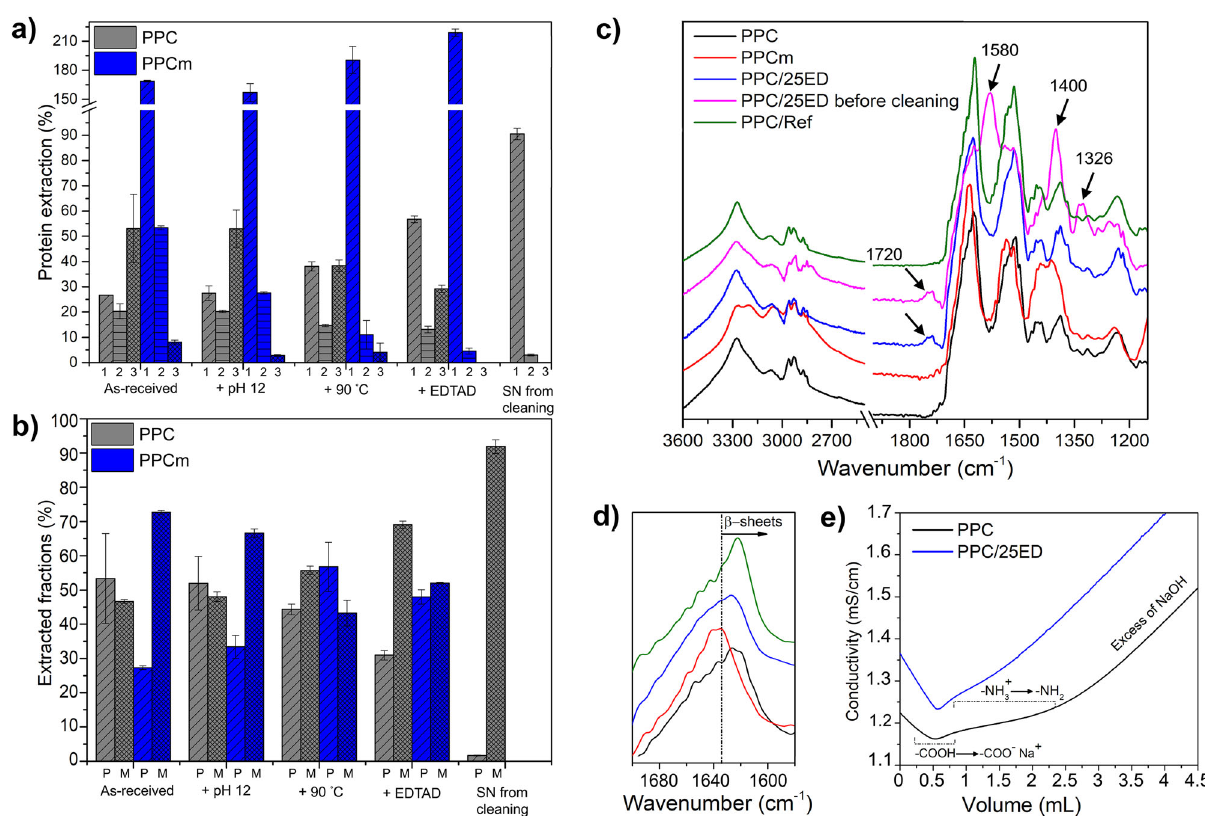
Fig. 2 Protein extraction pro fi les and functionalisation. a Three-step (1 – 3) protein extraction pro fi les, and b relation between polymeric (P) and monomeric (M) protein fraction ( b ) for conventional protein concentrate (PPC) and mildly extracted potato protein concentrate (PPCm) after the different functionalisation stages. The total extractable proteins for the as-received PPC were used as the normalisation value. SN from cleaning corresponds to a lyophilised aliquot of the SN of the cleaning of the PPC/25ED sample. Error bars represent ± one standard deviation. c Full FT-IR spectrum and d close-up of the amide I region. e Conductometric titration